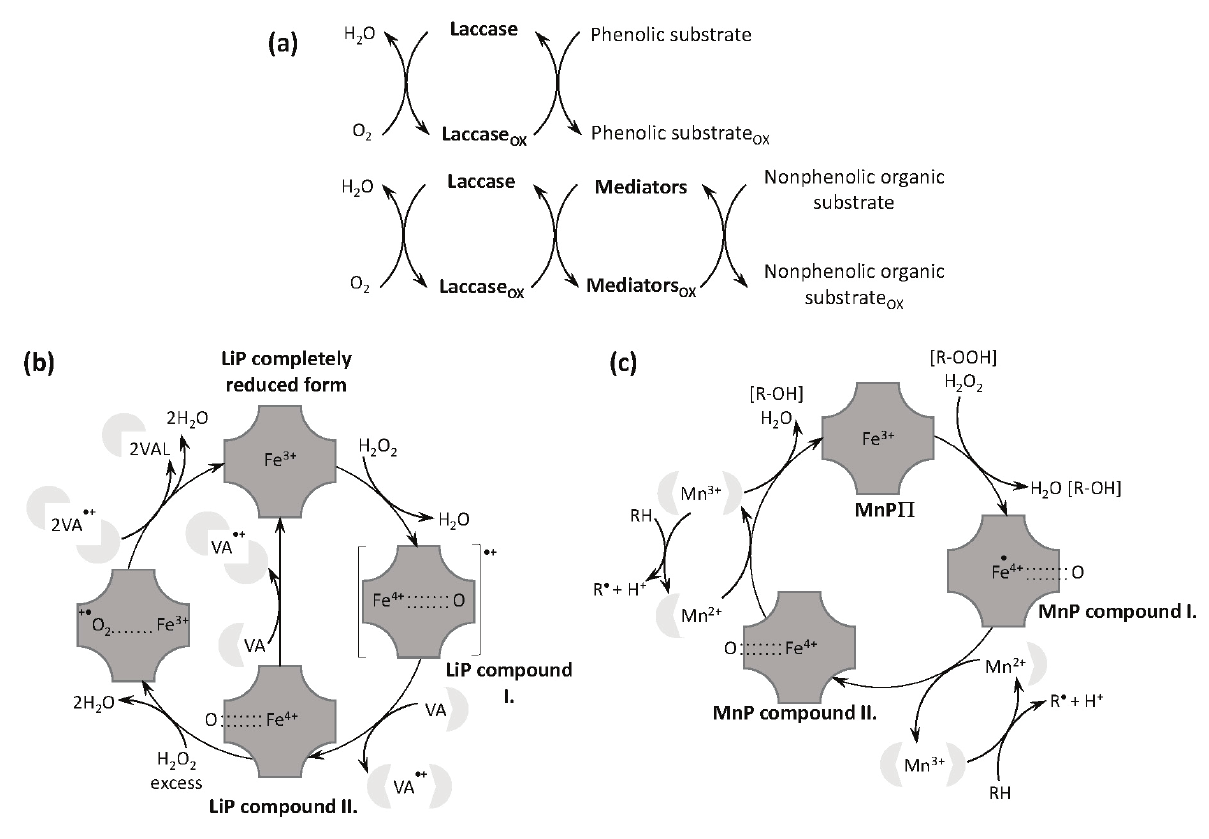
Fig. 2 – Catalytic mechanism of (a) laccase, (b) lignin peroxidase, (c) manganese